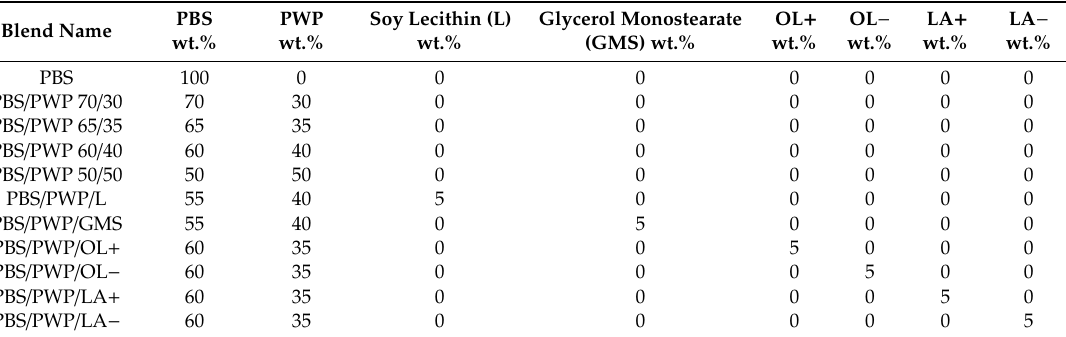
Table 4. Blends name and compositions.